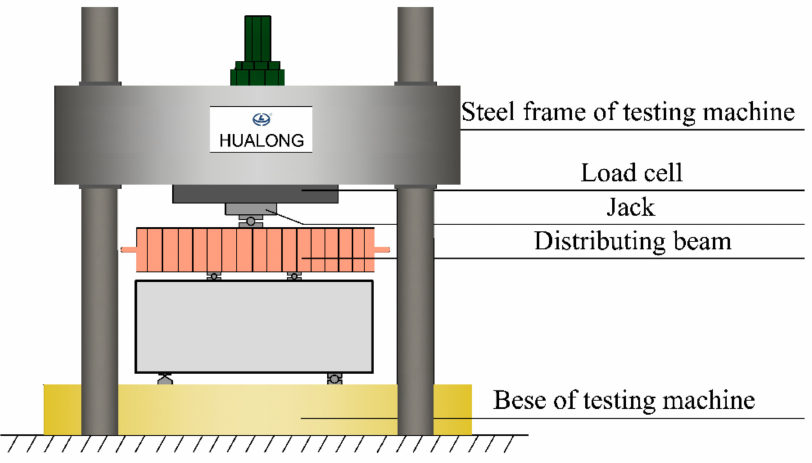
Figure 5. Schematic diagram of loading